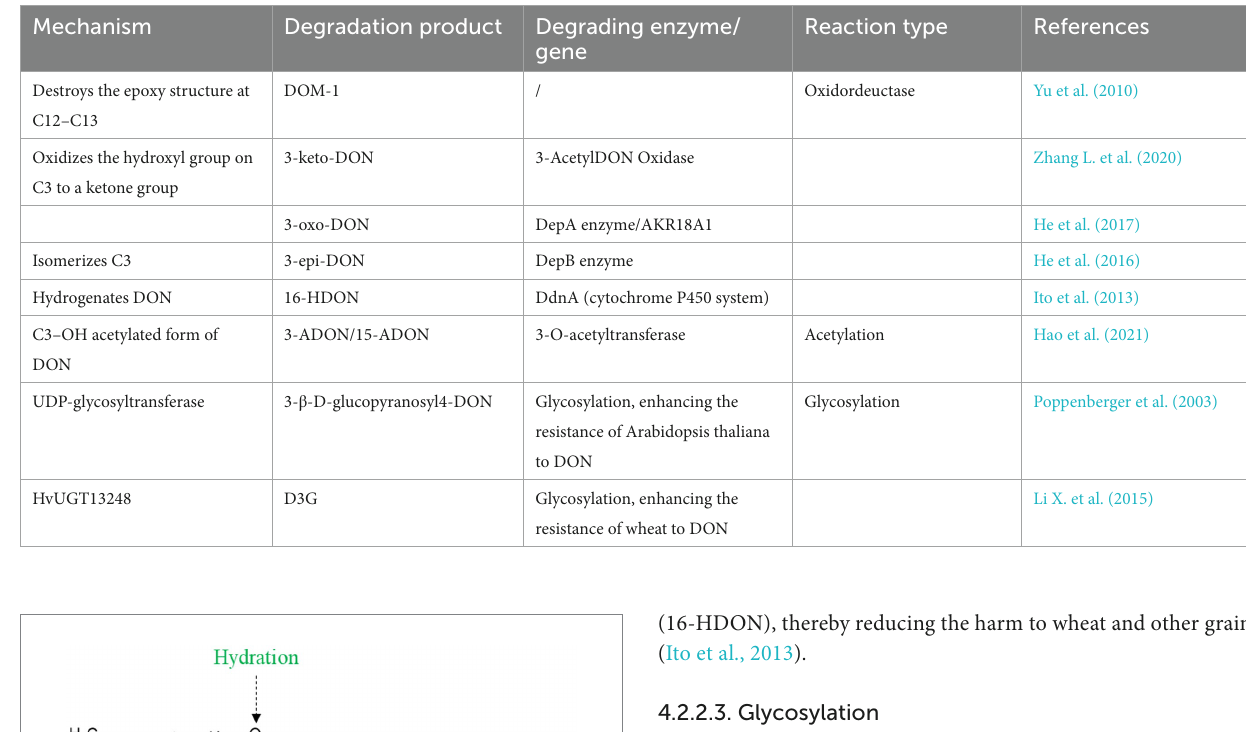
TABLE 5 DON degradation enzymes and their products.